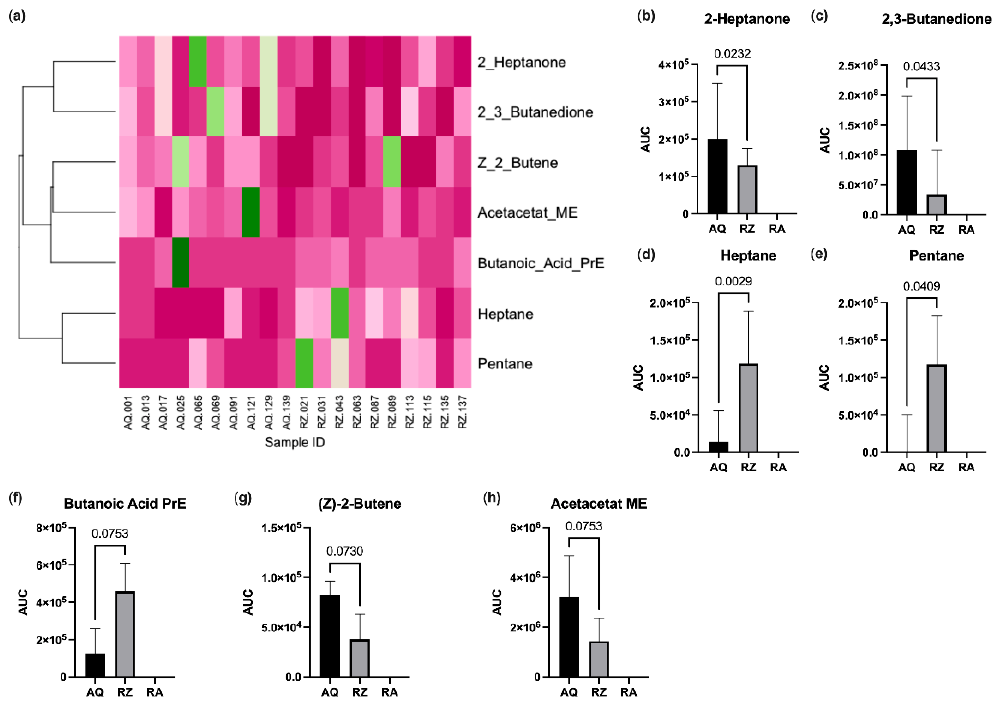
Figure 4. Results of the VOC analysis. ( a ) Heatmap with dendrogram. VOC values were normalized to the maximum; colors range from dark green (=1.0) to dark pink (=0.0); substances with significant changes ( b – e ) and with a trend between ( f – h ) the groups. AQ…aqua control group; RZ…(S)-reutericyclin group; RA…room air samples; PrE…propyl ester; ME…methyl ester.